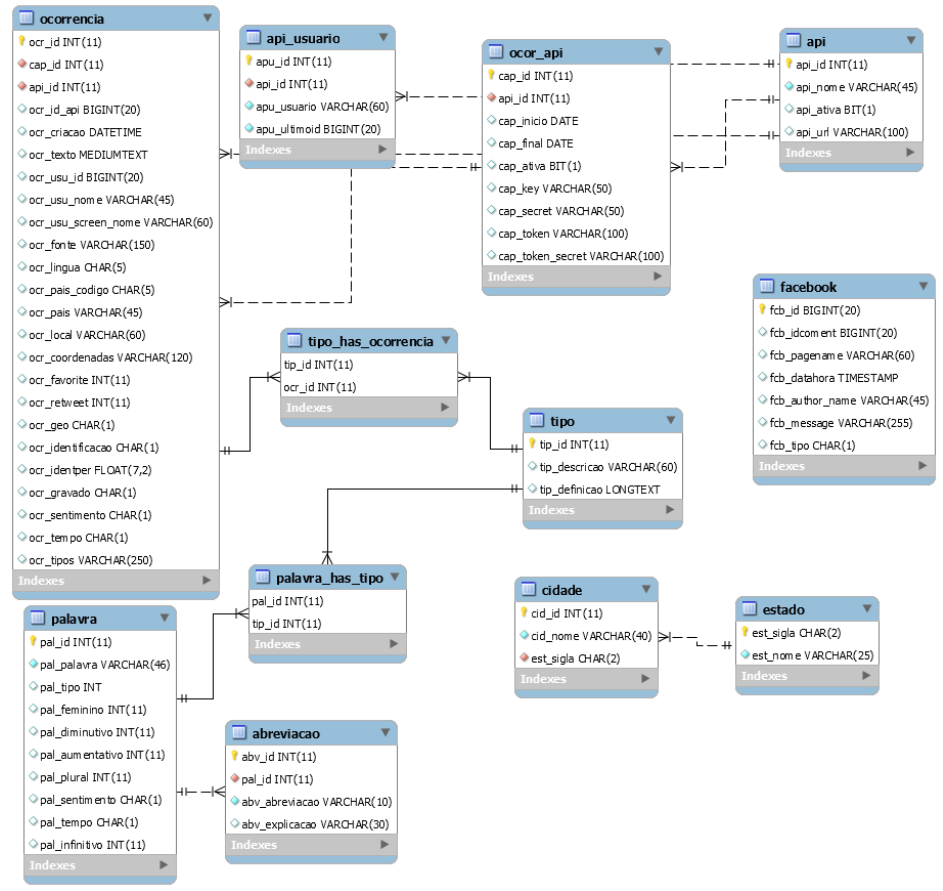
Figure 5. The database to store the dictionary of offensive